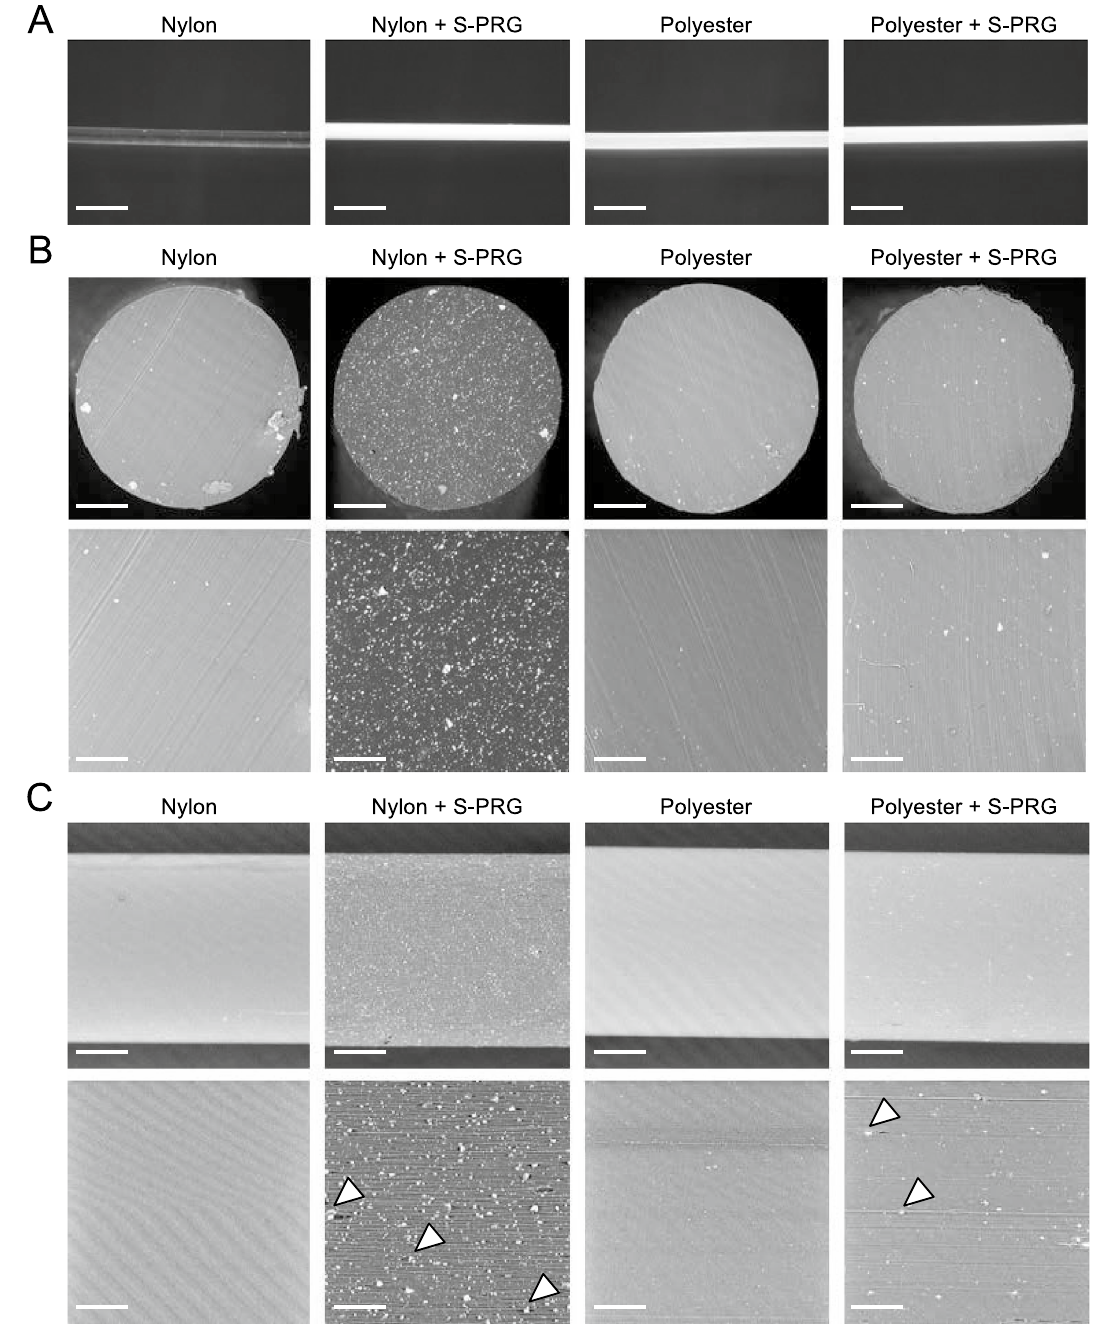
Figure 1. Structure of monofilaments with or without S-PRG filler. ( A ) Representative images of monofilaments (bar = 600 μm). ( B ) Transverse sections of monofilaments in scanning electron microscope (SEM) images. Upper panels show low-magnification images (bar = 50 μm) and lower panels show high- magnification images (bar = 30 μm). White particulate materials in the nylon and polyester monofilaments containing S-PRG filler are S-PRG filler. ( C ) Side structure of monofilaments in SEM images. Upper panels show low-magnification images (bar = 50 μm) and lower panels show high-magnification images (bar = 20 μm). Arrowheads indicate S-PRG filler that has penetrated into the monofilament